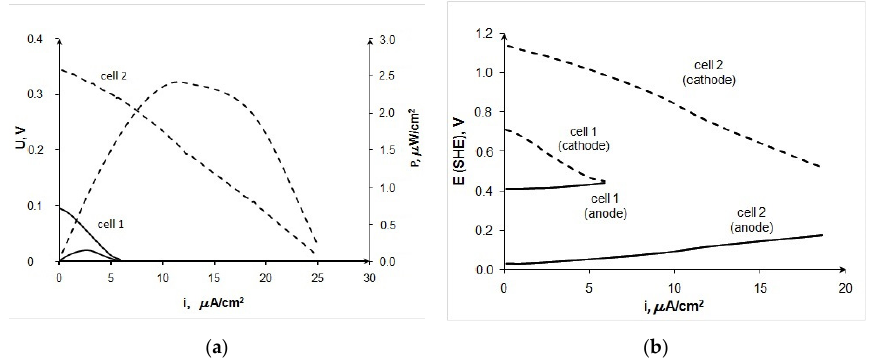
Figure 5. Comparison of characteristics for BFC 20Au / XC-72 (anode)—laccase (cathode), measured in the Electrochem ™ cell (cell 1) and in the developed BFC (cell 2), 0.2 M glucose, pH 4.7, ( a ) current–voltage curves, ( b ) partial